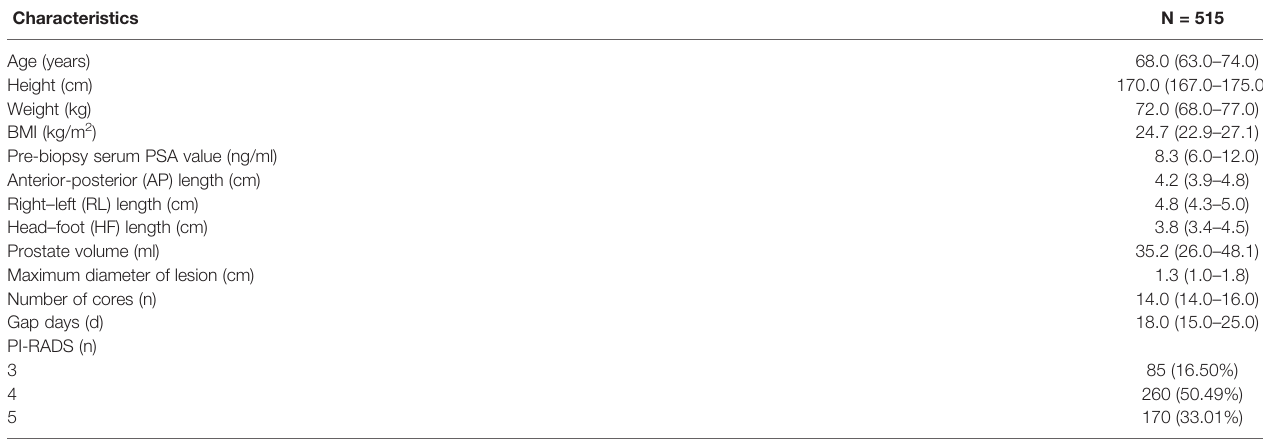
TABLE 1 | Clinical characteristics of